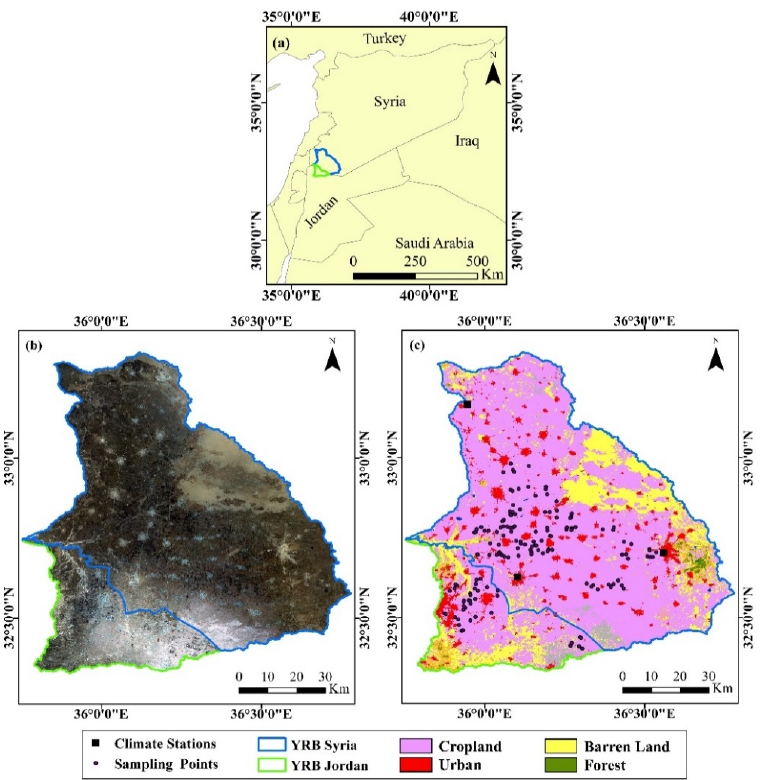
Figure 1. ( a ) Location map of Yarmouk River Basin (YRB) in Northern Jordan and Southern Syria, ( b ) a true Landsat-8 color image for 2021, and ( c ) land cover Map for YRB (CGLS, 2019).